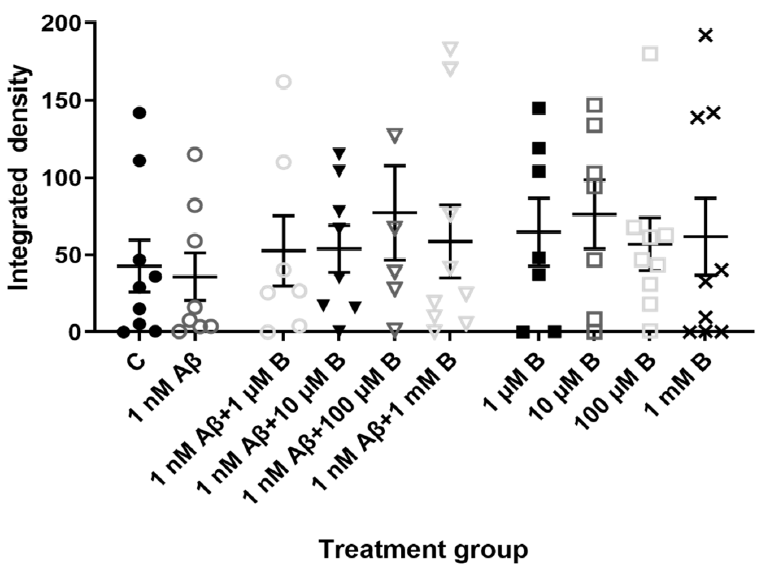
100 µ M ( p > 0.05, n = 7), and 1 mM ( p > 0.05, n = 6). Overall, there was no change in NKCC1 expression across all treatment groups.